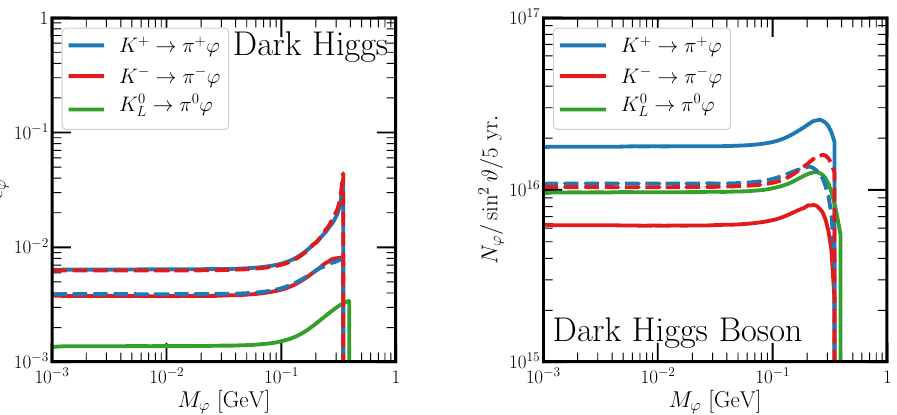
Figure 15 . Left panel: acceptance fraction (cid:15) ’ of dark Higgs particles as a function of their mass M ’ . The acceptance fraction is de(cid:12)ned as the fraction of all produced ’ that have their momentum pointing in the direction of the DUNE MPD at the time of their production. Right panel: expected number of dark Higgs particles ’ directed towards the DUNE MPD as a function of their mass M ’ , assuming (cid:12)ve years of data collection in both neutrino mode (solid lines) and antineutrino mode (dashed lines). We scale the number of particles to sin 2 # = 1. Solid (dashed) lines are for neutrino (antineutrino) mode, and blue, red, and green lines indicate ’ from K + , K (cid:0) , and K 0 L decays, respectively. The K 0 distribution is una(cid:11)ected by focusing and the distinction between L neutrino/antineutrino modes, and so there is no corresponding dashed green line. K 0 -produced ’ L allow for reaching larger values of M ’ as m m (cid:25) 0 > m K (cid:6) m (cid:25) (cid:6) K 0 L (cid:0) (cid:0)